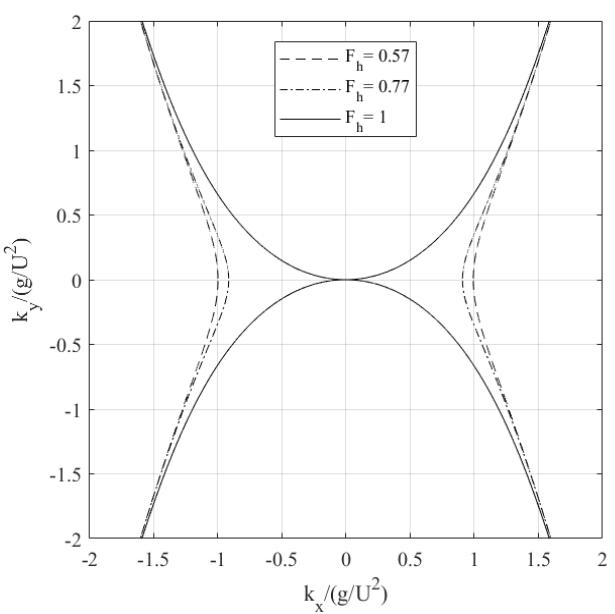
Figure 7. Solutions to Equation (8). Figure depicts the examined loci alongside the critical depth Froude number ( 𝐹 ℎ = 1 ) to demonstrate the effect of speed.